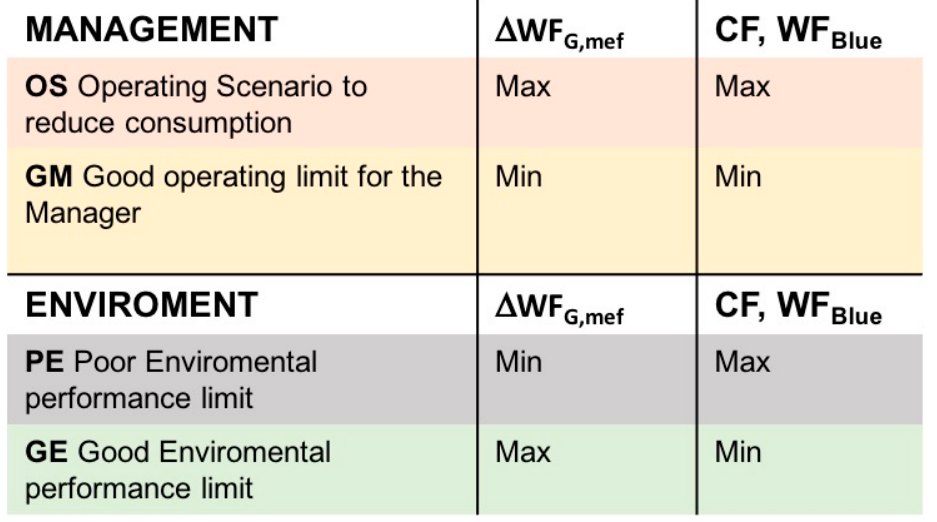
Figure 4. ∆ WF G,mef , WF Blue and CF values corresponding to descriptions of different scenarios identified. GE, good environmental performance limit; GM, good manager performance limit; OS, operational scenario to reduce consumption; PE, poor environmental performance limit.